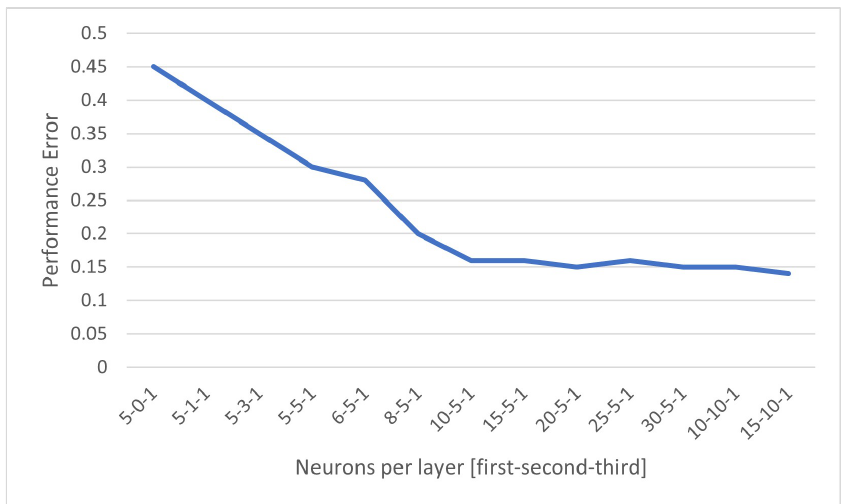
Figure 5. Performance error versus network size with 13 final